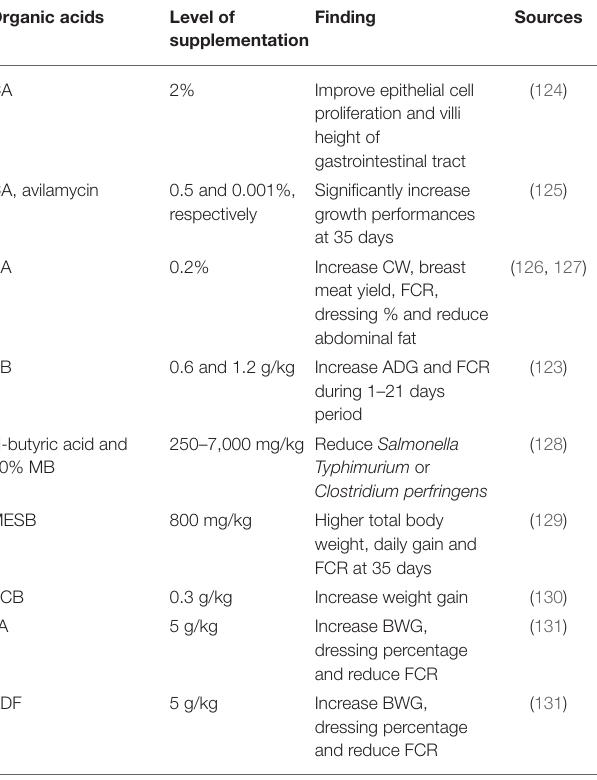
TABLE 2 | Organic acids, their derivatives, and ameliorative effects on broiler production. Organic acids